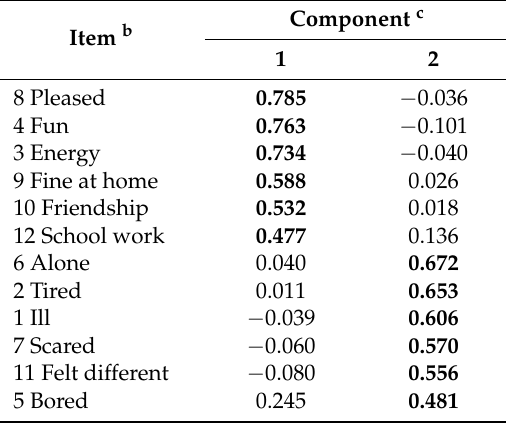
Table 6. Factor loadings in the explanatory factor analysis a of the HRQoL scale (N = 1253). Component Item b